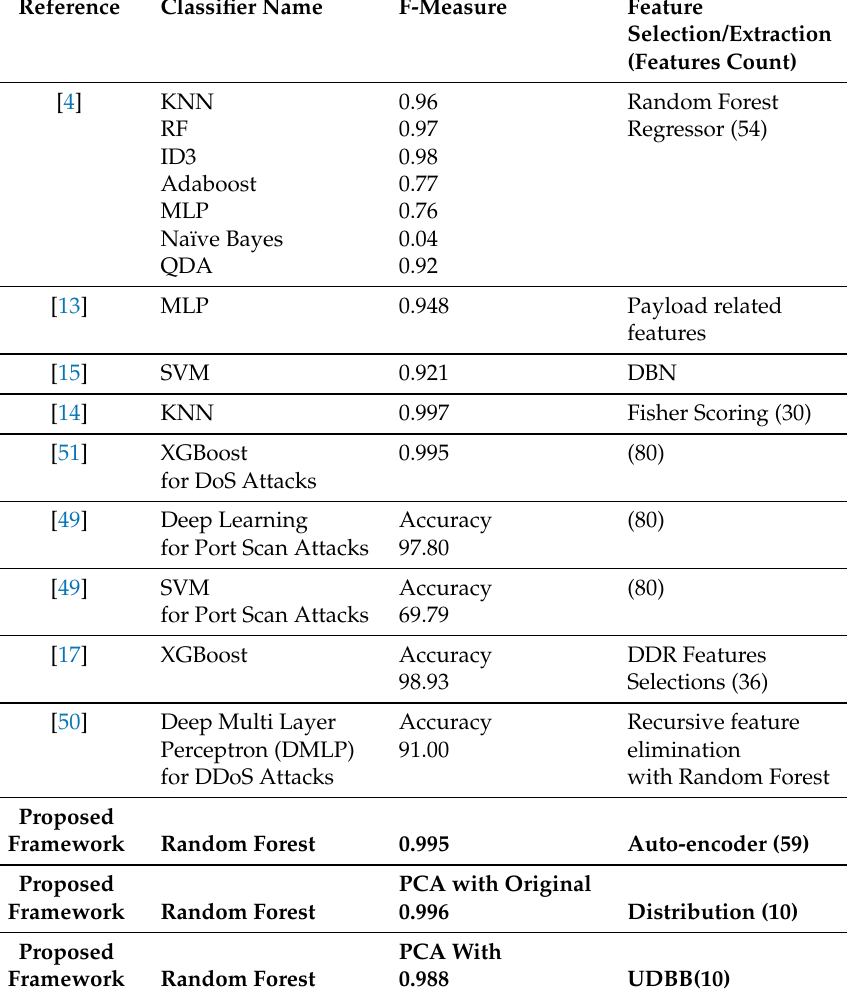
Table 16. A comparison of the proposed framework and previous